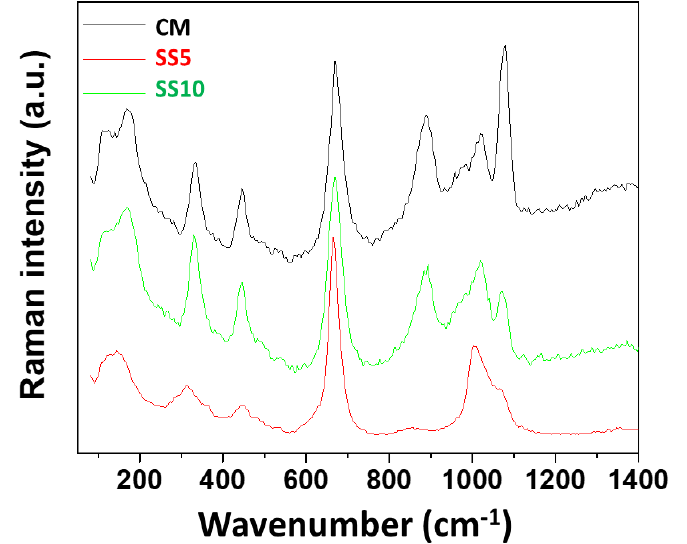
Figure 11. Raman spectra of the mortar surfaces after 28 days of curing.